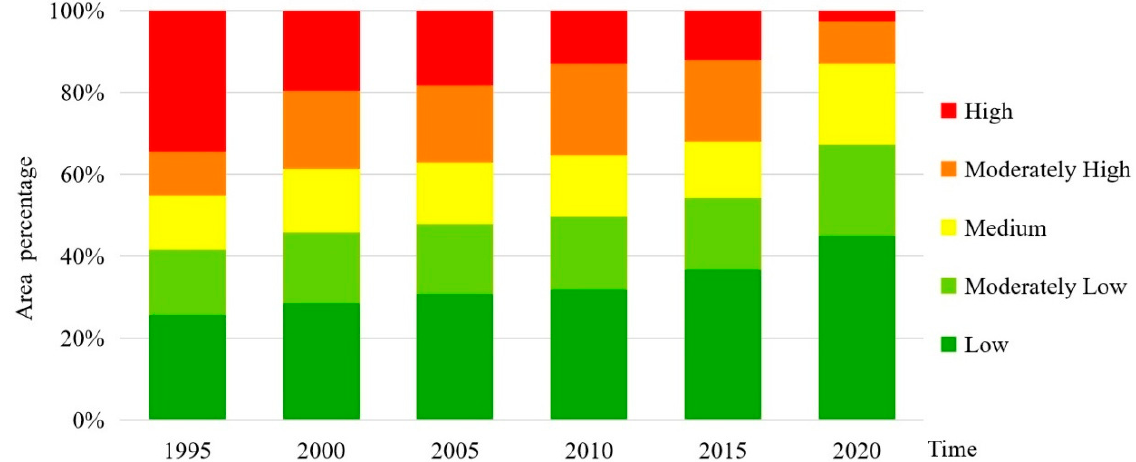
Figure 3. Change trend of ecological risk levels in the Dongting Lake area from 1995 to 2020.